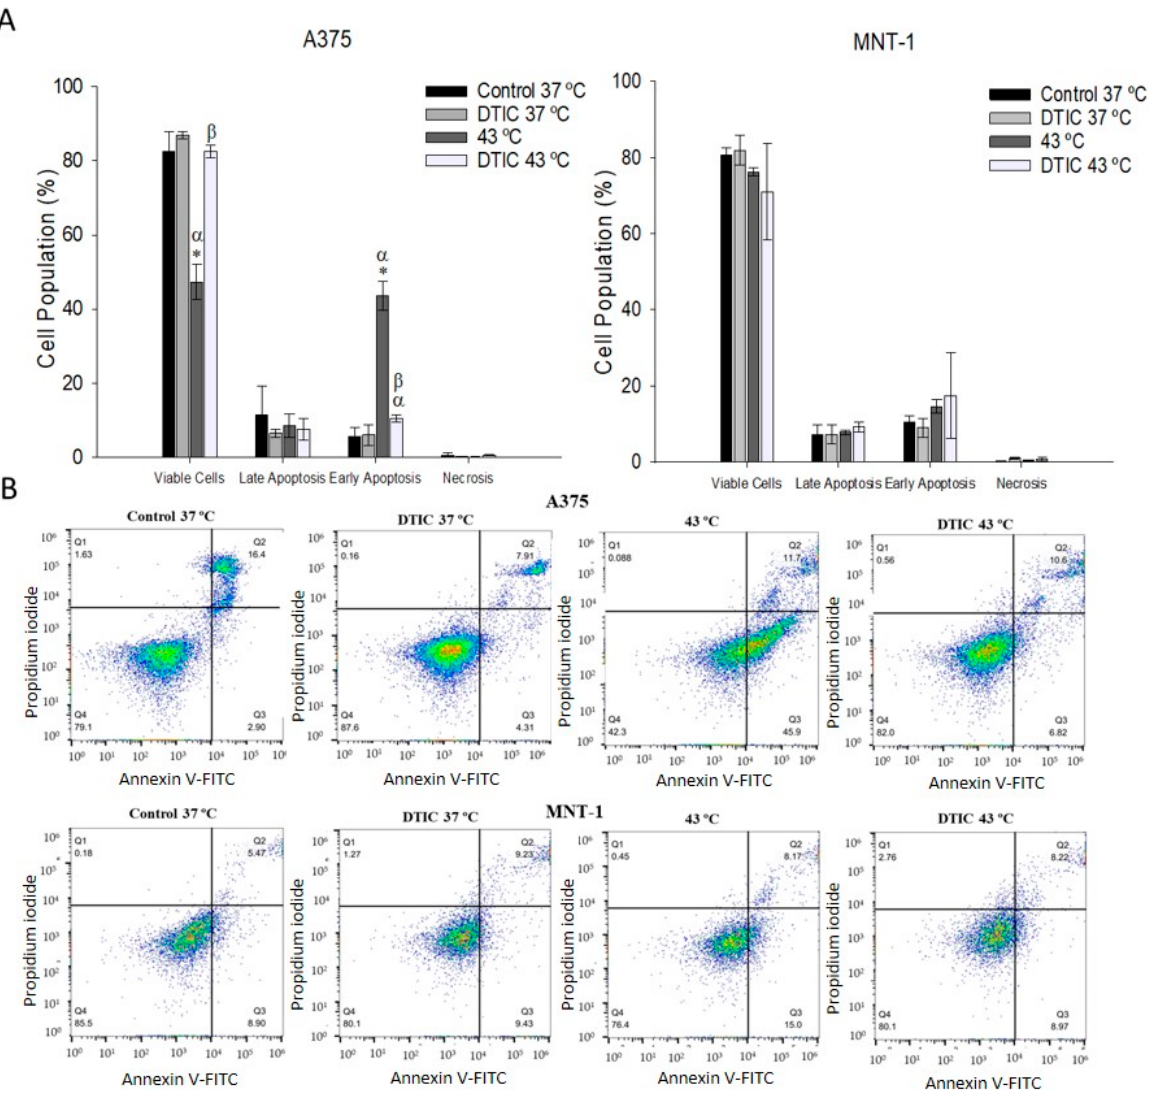
Figure 7. Effect of DTIC and hyperthermia combination on apoptosis in A375 and MNT-1 cell lines. Both cell lines were exposed to 43 °C for 30 min and A375 were treated with 5.5 μ g/mL and MNT-1 cells with 115 μ g/mL of DTIC for 48 h. ( A ) Apoptotic cells (%) after treatment in groups analogous to viable and non-apoptotic; early and late apoptotic cells; ( B ) representative histograms of Annexin V-FITC/Propidium iodide. Data shown are the mean values ± standard deviation of two independent experiments, with two technical replicates each, and each replicate with at least 5000 events. * indicates statistical significance in comparison to the control 37 °C, α indicates statistical significance in comparison to the respective condition at 37 °C, and β indicates statistical significance of the conditions with hyperthermia in comparison to hyperthermia alone ( p < 0.05).